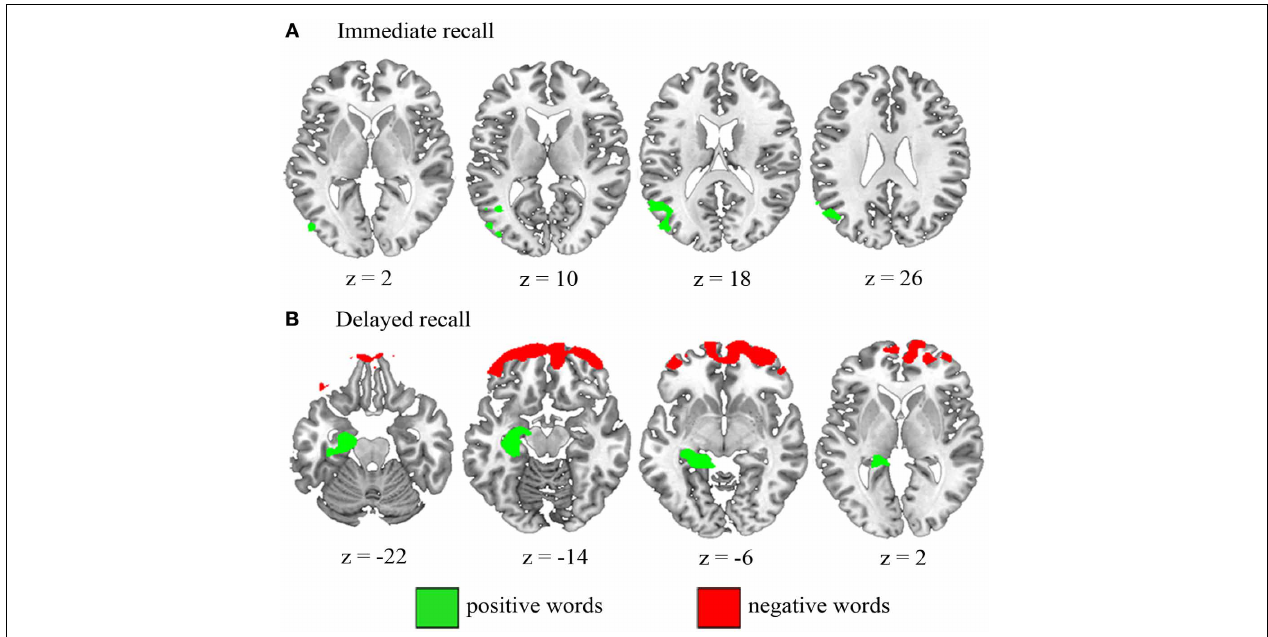
FIGURE 1 | Neuroanatomical regions where poorer performance at (A) immediate recall and (B) delayed recall was associated with decreased volume byvalence. Therewerenosignificantresultsfornegativewordsatimmediaterecall.Resultsarethresholdedat p < 0 . 01.MNIcoordinatesarereportedandL = L.